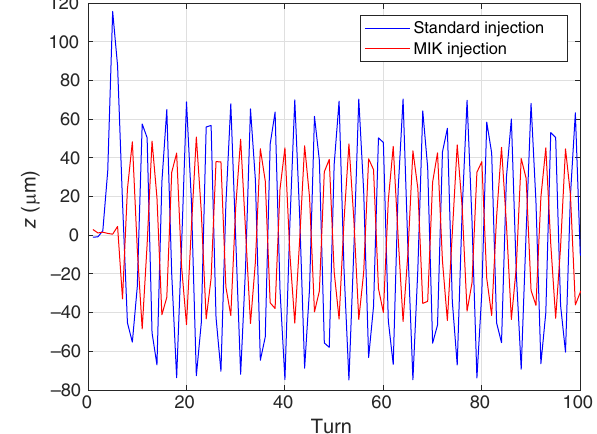
FIG. 12. Residual vertical betatron oscillations due to the four kickers (blue) and the MIK (red). Measurements with β z ¼ 8 . 6 m.